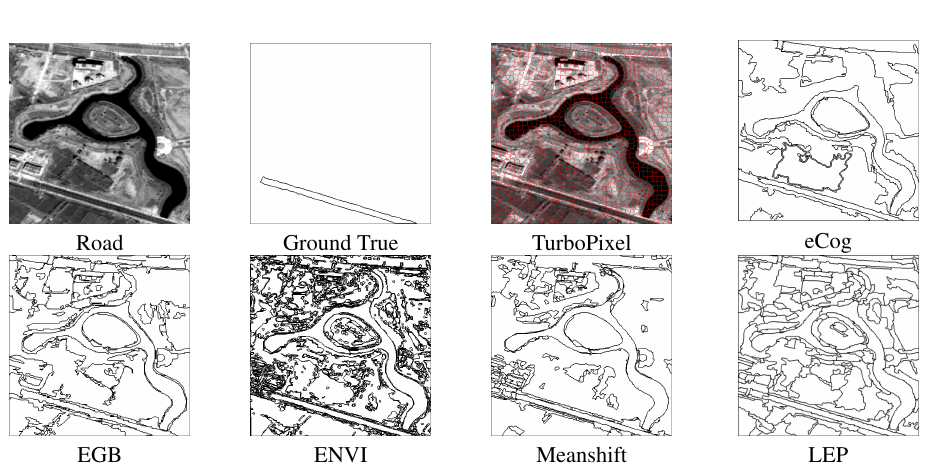
Figure 5: Road segmentation results, with the GHD values shown in Table 1